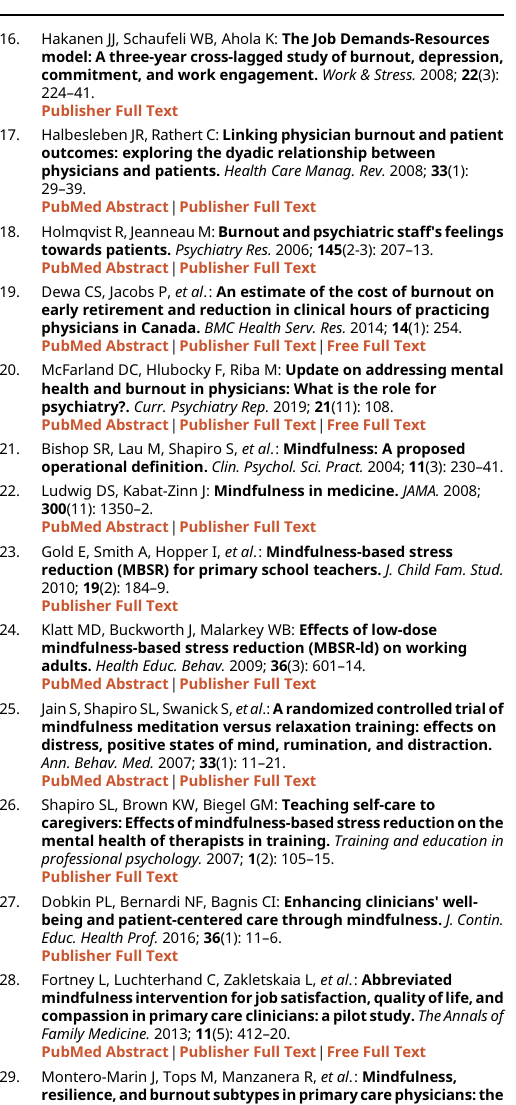
Figshare: De-identified qualitative responses. https://doi.org/10.6084/m9.figshare.16757029.v1.